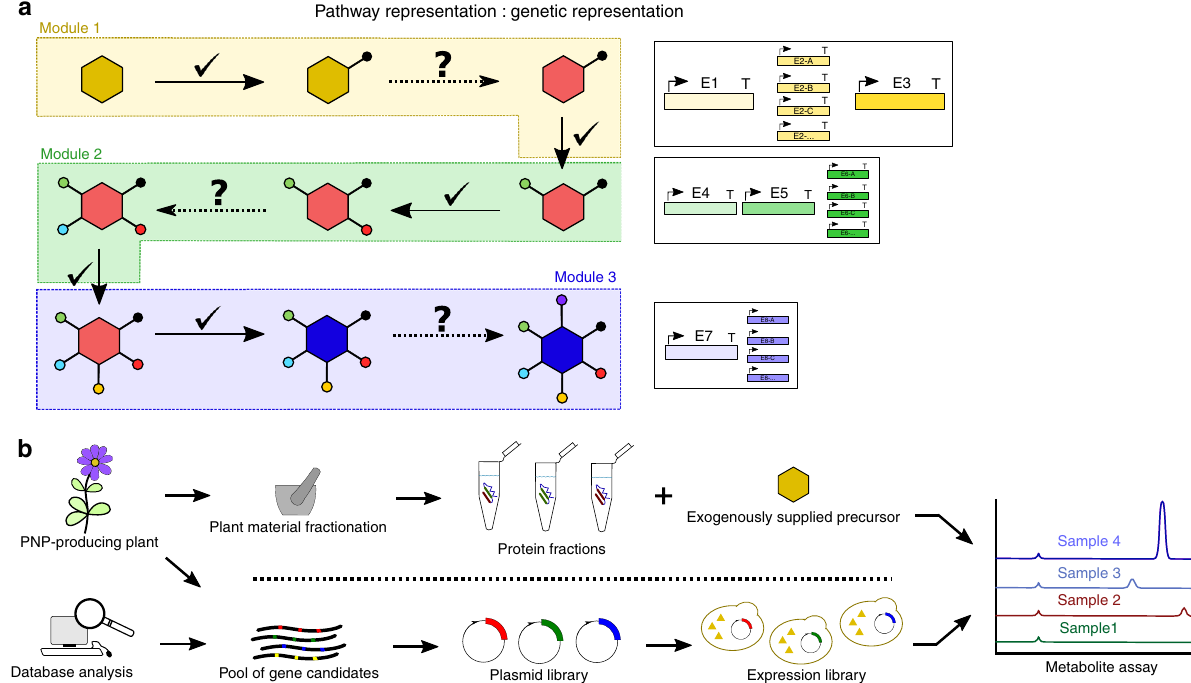
Fig. 3 Pathway engineering can be broken down into enzyme module and discovery components. a Example of a modular approach to construction of an eight-enzyme pathway; show at the level of pathway and corresponding genetic modules for testing. Note that each module contains 2 – 3 enzymes, only one of which is unknown (represented by dotted arrow with question mark), thus distributing critical unknown steps amongst the modules to be tested independently. b Strategies for identi fi cation of an unknown enzyme in a pathway. Starting either with the native PNP-producing plant or a database of genes containing known or putative enzyme activity, a pool of potential genes can be identi fi ed and then cloned into a library of plasmids, which are then used to generate a library of host cells expressing the gene candidates. Gene candidates can then be screened for production of the metabolite of interest. Conversely, in the absence of guiding genetic information, the plant material can be fractionated and separated as best as possible into its constituent proteins, to which the precursor for the desired enzymatic transformation is added, and then screened for production of the metabolite of interest. The latter strategy requires additional steps to determine the sequence of the gene encoding the active